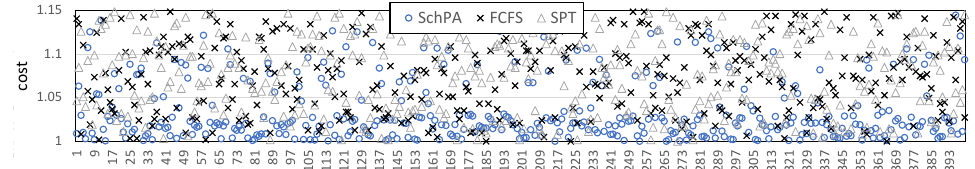
Figure 7. ARPD corresponding to Figure 6.